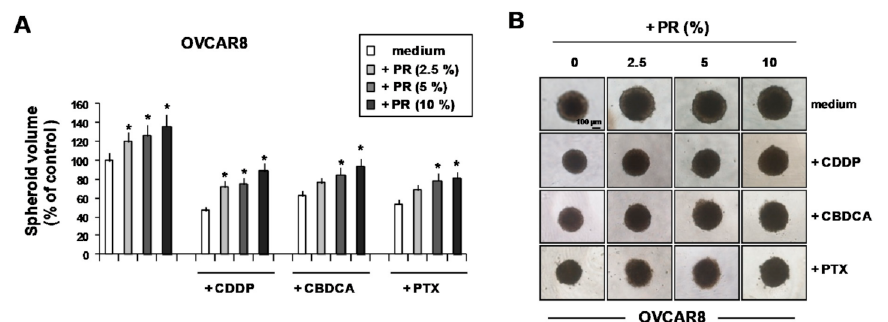
Figure 5. PR increased the volume of OVCAR8 spontaneously-formed single spheroids and decreased their growth inhibition due to CDDP, CBDCA and PTX. Three-day-old OVCAR8 spheroids were treated with increasing concentrations of PR for 24 hours, then for an additional 3 days with CDDP, CBDCA and PTX. ( A ) Responses were evaluated by measuring the volume of at least three spheroids. ( B ) Representative phase-contrast microphotographs showing the volume of OVCA8 spheroids treated with PR, drugs and the combination drugs/PR. Data are expressed as mean ± SD of three replicates with three different PR pools and represent the percentage with respect to control medium. * p < 0.05 (untreated vs. PR-treated